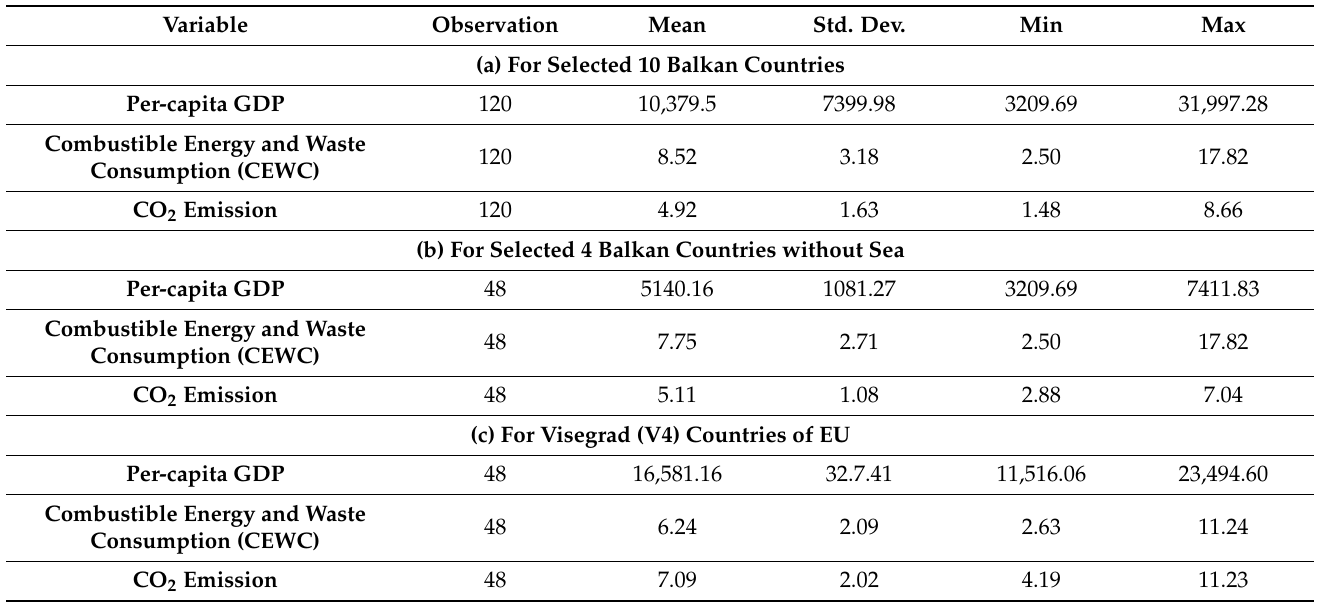
Table 1. Descriptive